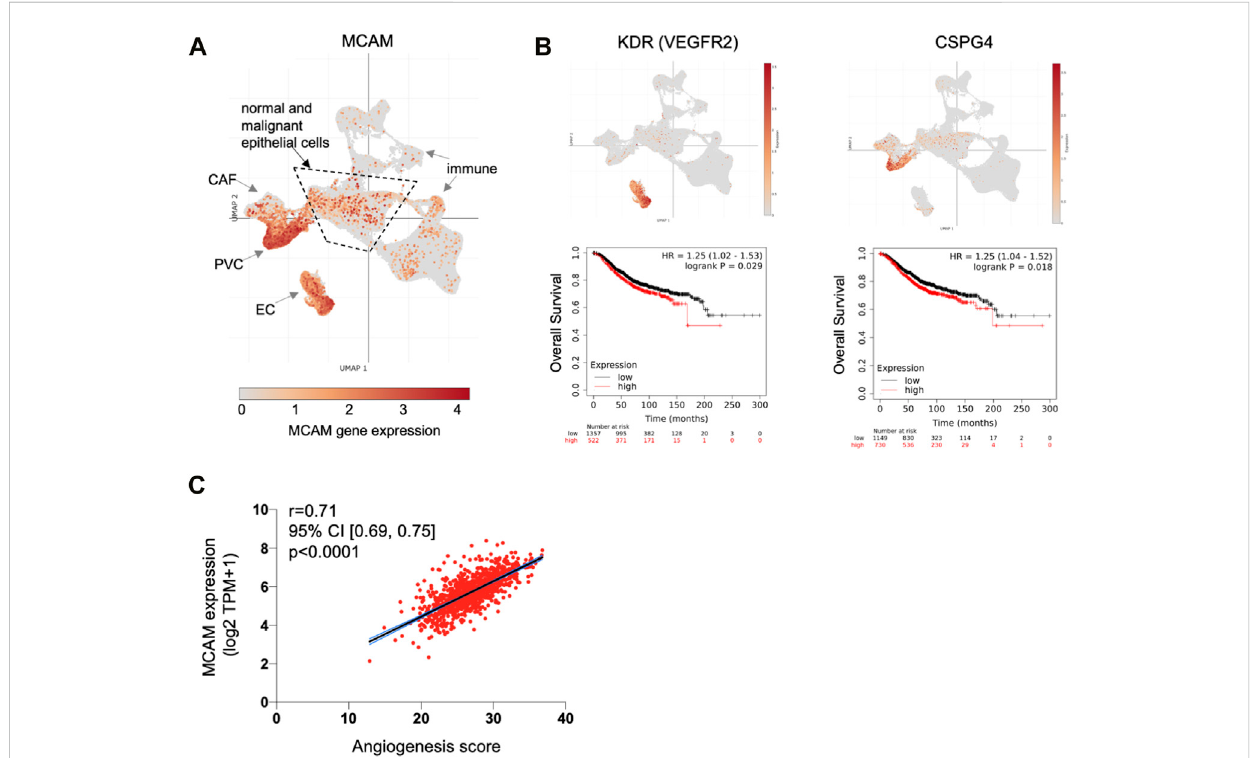
FIGURE 6 MCAM gene expression at the single cell level in human breast cancer. (A) Uniform Manifold Approximation and Projection (UMAP) of a complete breast cancer scRNA-seq dataset comprising 100,064 cells from 26 patients. This data is from the study of Wu et al. (2021) with major cell populations indicated, as previously de fi ned; these include immune cell types, cancer associated fi broblasts (CAF), endothelial cells (EC) and perivascular cells (PVC), as well as the epithelial cells (bothmalignantand normal) within thecentral area as indicated. Expression of MCAM is indicated and superimposed in orange.DatawasdisplayedandanalysedusingSingleCellPortal. (B) UMAPofthecompletesc-RNAseqdatasetshowingexpressionoftheendothelialcell markergeneKDR(VEGFR2)andthePVCmarkergeneCSPG4(superimposedinorange).BeloweachUMAPareKaplanMeierplotsshowingoverallsurvival in 1879 breast cancer patients strati fi ed for KDR and CSPG4 gene expression, as determined using KM plotter (Györffy et al., 2010). (C) Correlation of angiogenesis score with MCAM gene expression across a cohort of 1,093 breast cancer patients from TCGA. Spearman ’ s r and the 95% con fi dence intervals (with associated p -value) are